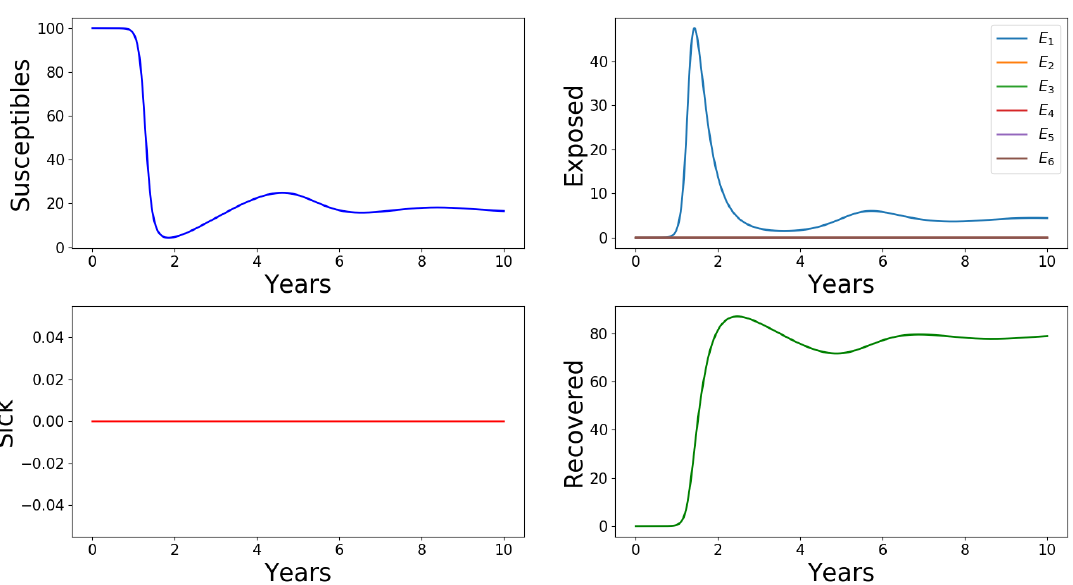
Figure 3. Profiles for all the variables of Model (1)–(6). The horizontal axes scale the time in days and the vertical axes scale the population sizes percentages. The first infectious case arises in the population E 1 and does not spread to the other infectious classes. ‘Sick’ humans are those of the class I who show clinical signs of the disease. ORS =